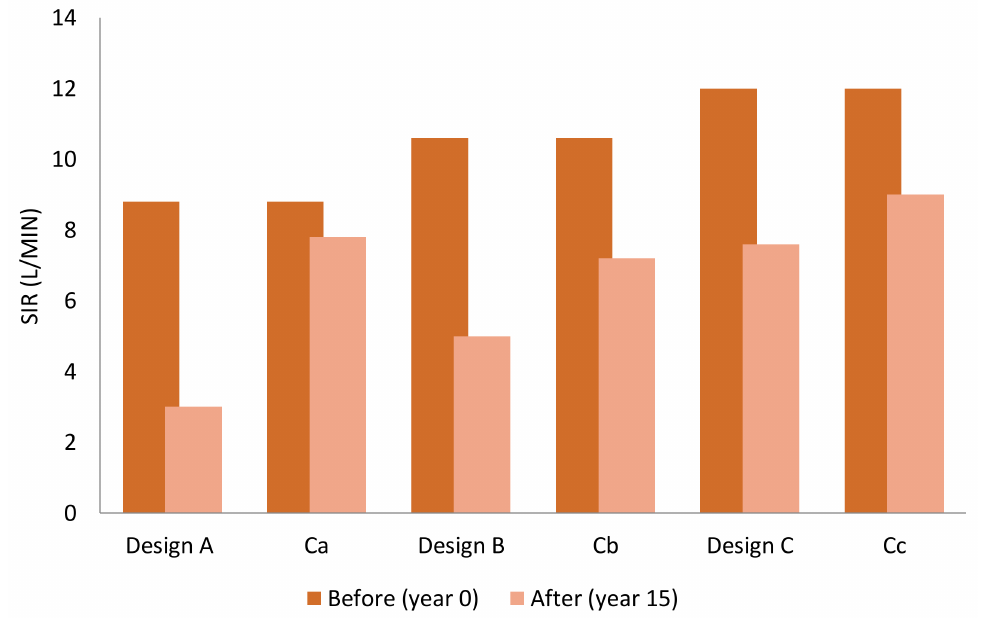
Figure 6. The average surface infiltration rate (SIR) before and after 15 years’ stormwater and sediment application (Cycle